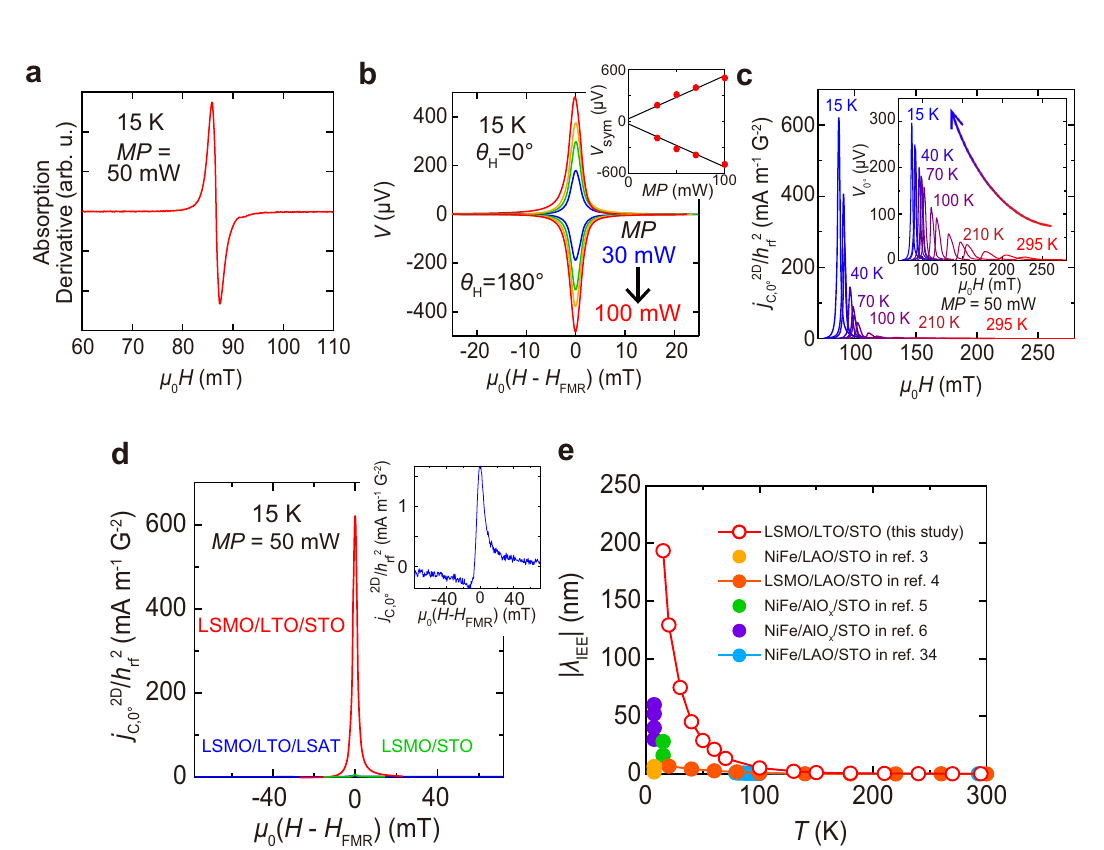
Fig. 2 | Electrical and magnetization properties of LSMO/LTO/STO and LSMO/ LTO/LSAT. a Temperature ( T ) dependence of the sheet resistance R sheet of the LSMO(30u.c.)/LTO(3u.c.)/STOandtheLSMO(30u.c.)/LTO(3u.c.)/LSATsamples. b T dependence of the magnetization M of LSMO (30u.c.)/LTO (3u.c.)/STO and LSMO (30u.c.)/LTO (3u.c.)/LSAT. The Curie temperatures of LSMO/LTO/STO and